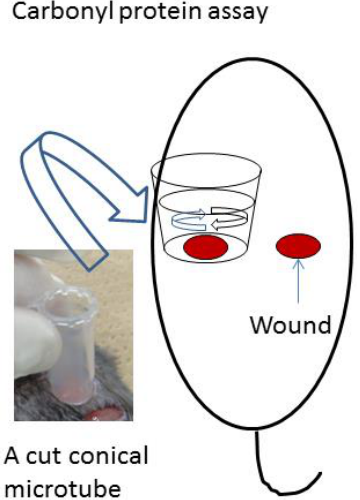
Figure 6. Scheme of experiments on carbonyl protein. A cut conical microtube with phosphate-buffered saline (PBS) was placed on the wound, which was gently washed on days 2, 4, 7, and 9. The washes were collected and measured for the amount of carbonyl protein. The data were analyzed in Figure 7.